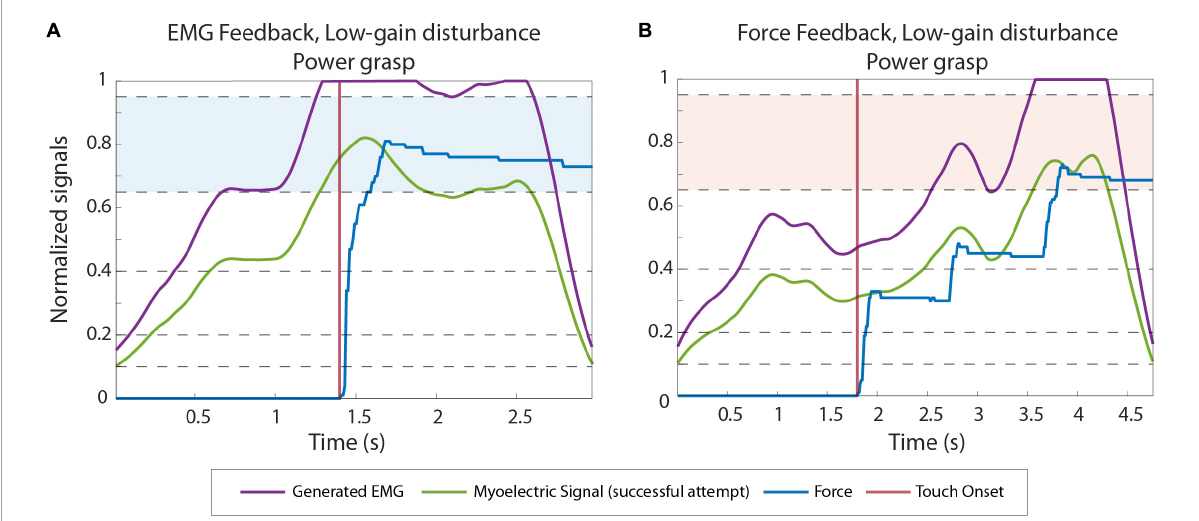
FIGURE5 Example EMG and force traces recorded during low gain disturbed trials from subjects using EMG (A) and force feedback (B) . The green and blue lines correspond to the myoelectric (ME) signal and the force applied in the last (successful) attempt in a trial, respectively. The purple lines are the ME signals produced by the subjects before the signal is multiplied by the disturbance gain. The contact points (when the prosthesis contacts the object) are denoted by the vertical red lines. The target levels in each trial are highlighted with blue and red colored bands.